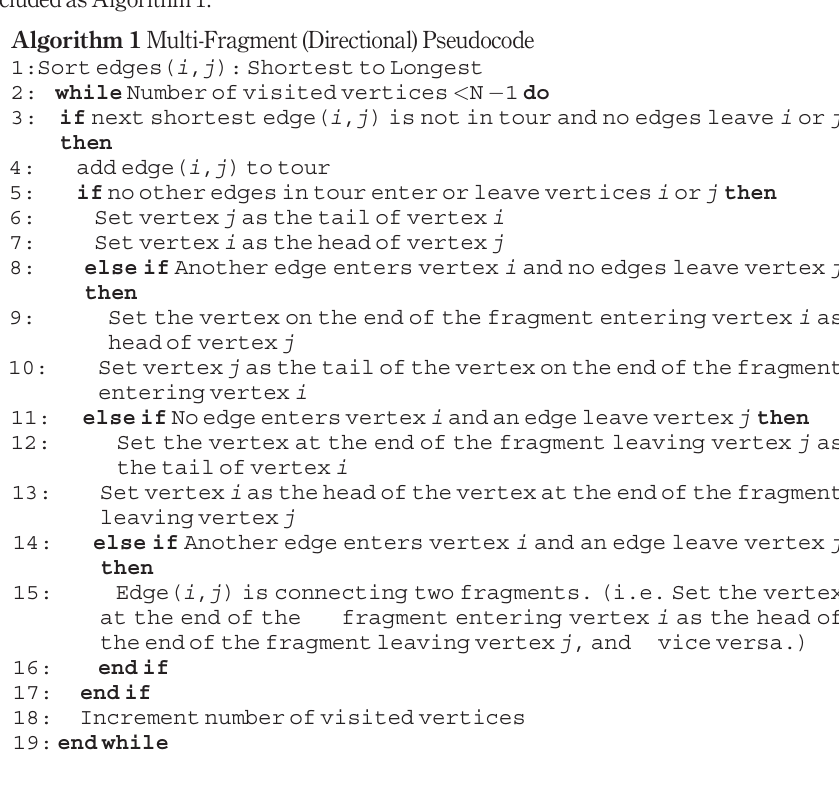
Algorithm 1 Multi-Fragment (Directional)